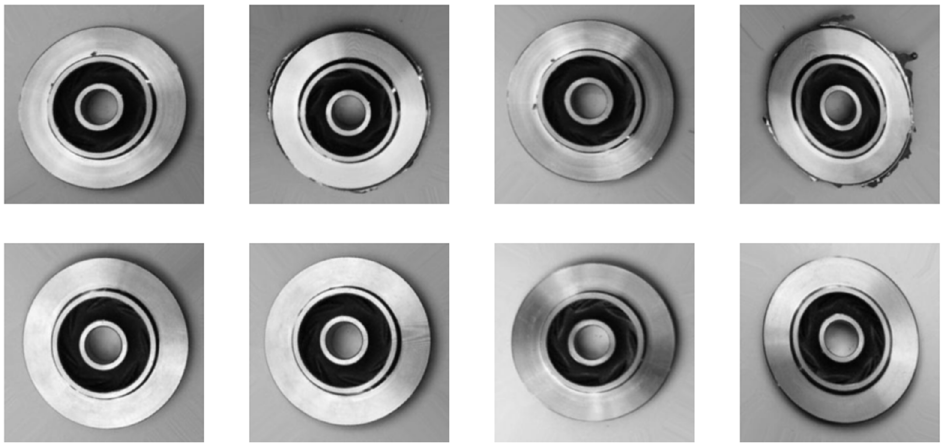
Figure 4. Defective and defect-free product samples [43].